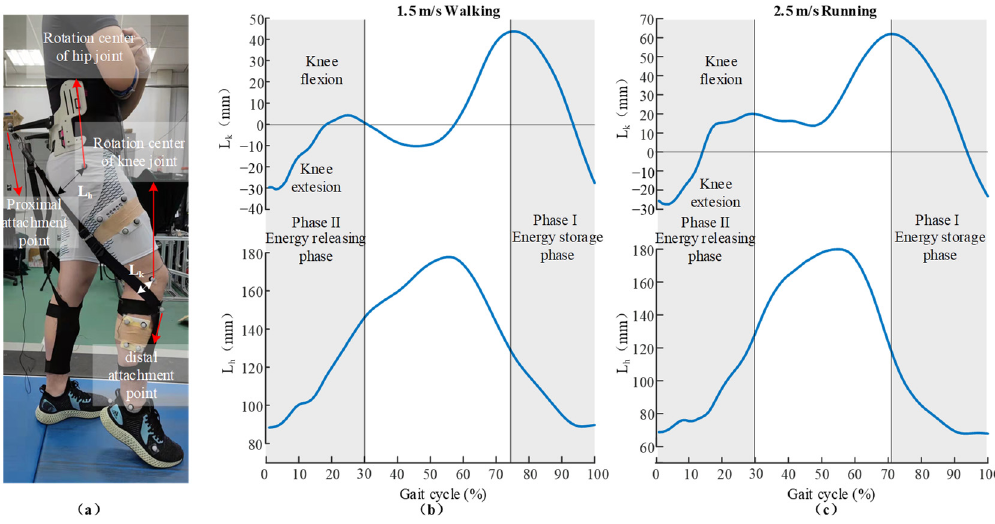
Figure 4. ( a ) The attachment points and real lever arms for hip and knee joints. ( b , c ) The length changes in hip lever arm (L h ) and knee lever arm (L k ) in gait Table 1. The mass distribution of unpowered hip–knee exoskeleton.